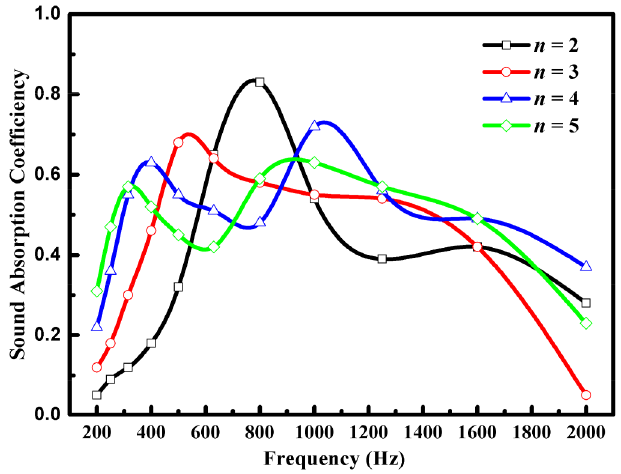
Figure 6. Effect of layer number on sound absorption efficiency of the BT/NBR-PUSF